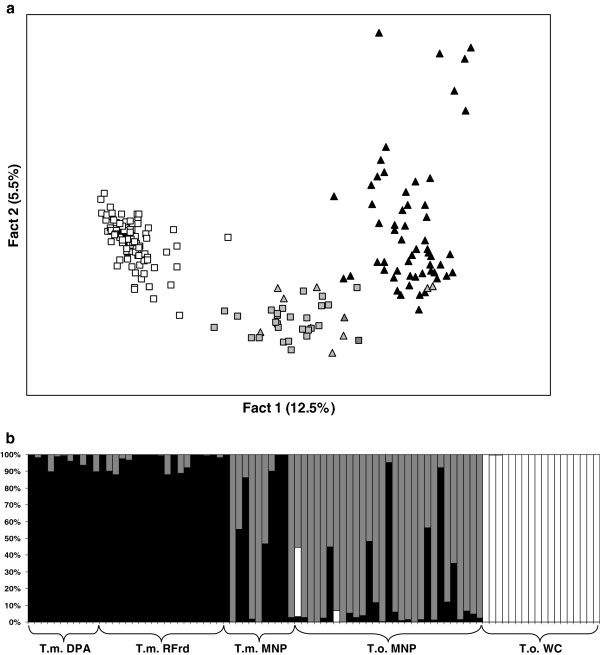
Testing hybridisation patterns at a distributional overlap zone (T. oreades and T. mongaensis at Monga NP).a) Factorial analysis comparing all individuals from all tested populations from T. oreades (white squares) and T. mongaensis (black triangles). The individuals from the Monga NP site morphologically assigned to either of the two species are represented in grey. b) NewHybrids results comparing the individuals (single bars) from the Monga NP site to the geographically closest populations of T. mongaensis (Dasyurus PA, River Forest Road) and T. oreades (Waratah Creek). T.m. DPA: T. mongaensis – Dasyurus PA; T.m. RFrd: T. mongaensis – River Forest Road; T.m. MNP: T. mongaensis – Monga NP (sympatric); T.o. MNP: T. oreades – Monga NP (sympatric); T.o. WC: T. oreades – Waratah Creek. Black represents% assignment to T. mongaensis genotype, white represents% assignment to T. oreades, grey represents% assignment to hybrid.